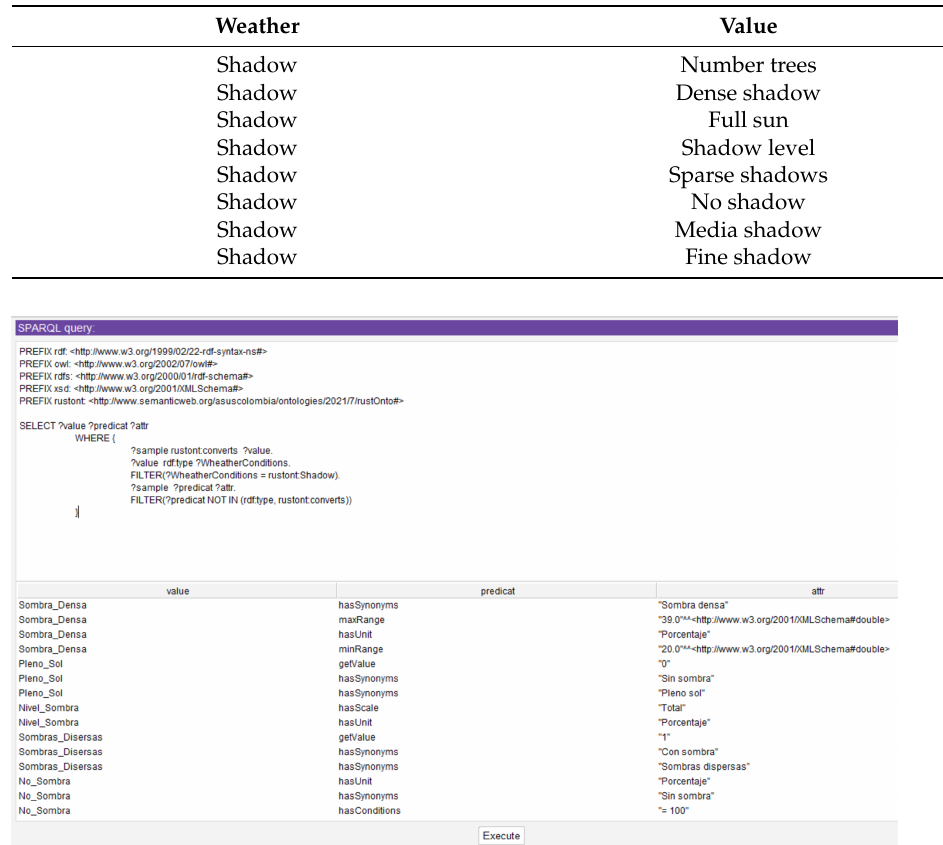
Table 10. Query result for Scenario 3 using Protégé., Weather indicates the name of the class and Value denotes the allowed values for the class, execution time was 74 ms.